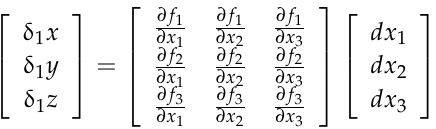
Table 1. Error transfer coefficient of two